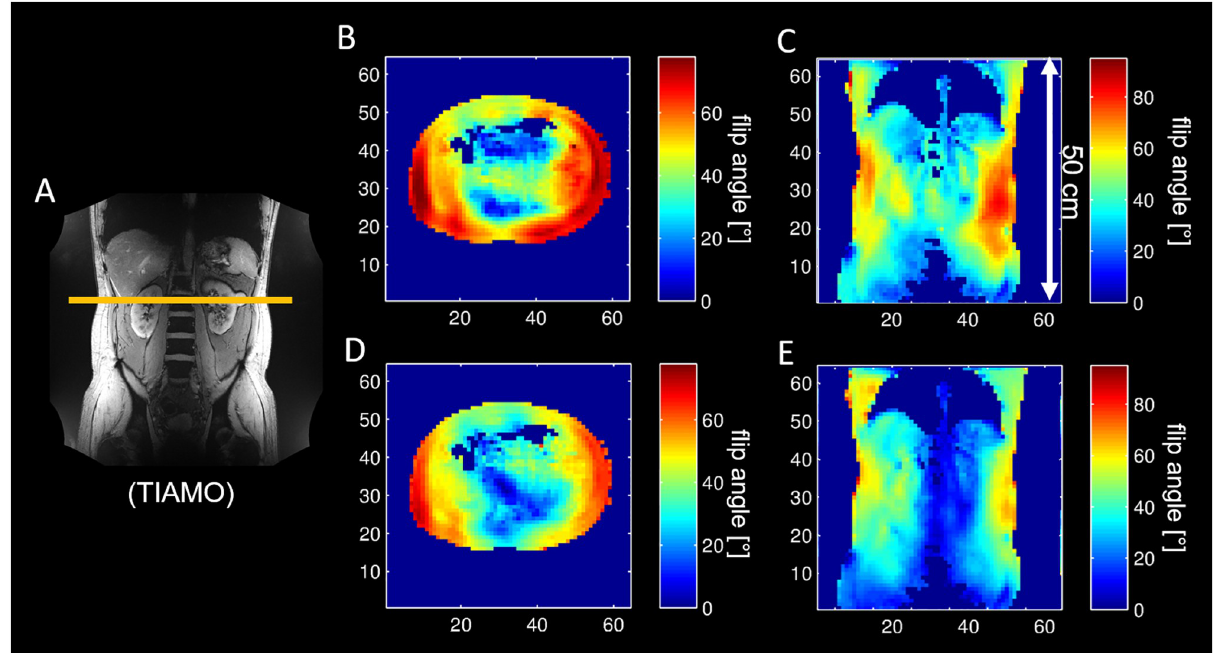
Fig 8. In-vivo flip angle maps. In-vivo flip angle maps with TIAMO image (A) for orientation. The maps show the CP+ (B, C) and CP2+ (D, E) modes in transverse (B, D) and coronal (C, E) orientation. The maps (C,E) have a field of view of 50 cm in z-direction.